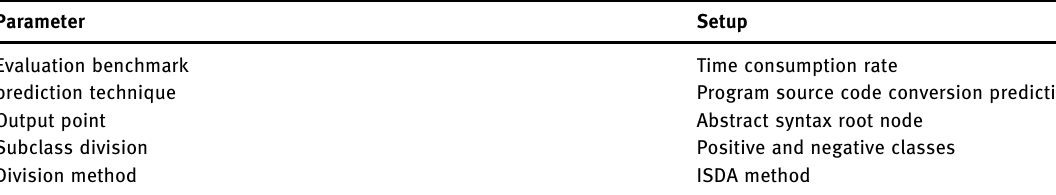
Table 2: Experimental